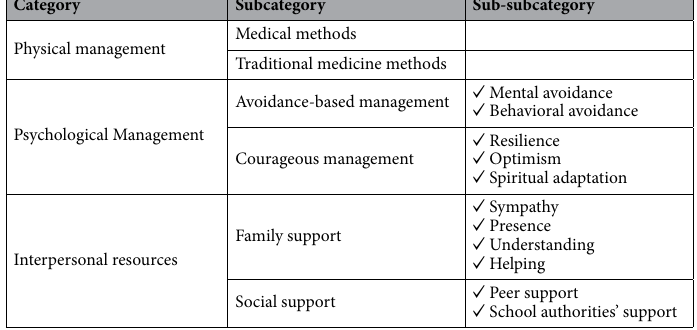
Table 5. The categories, subcategories, and sub-subcategories in the qualitative